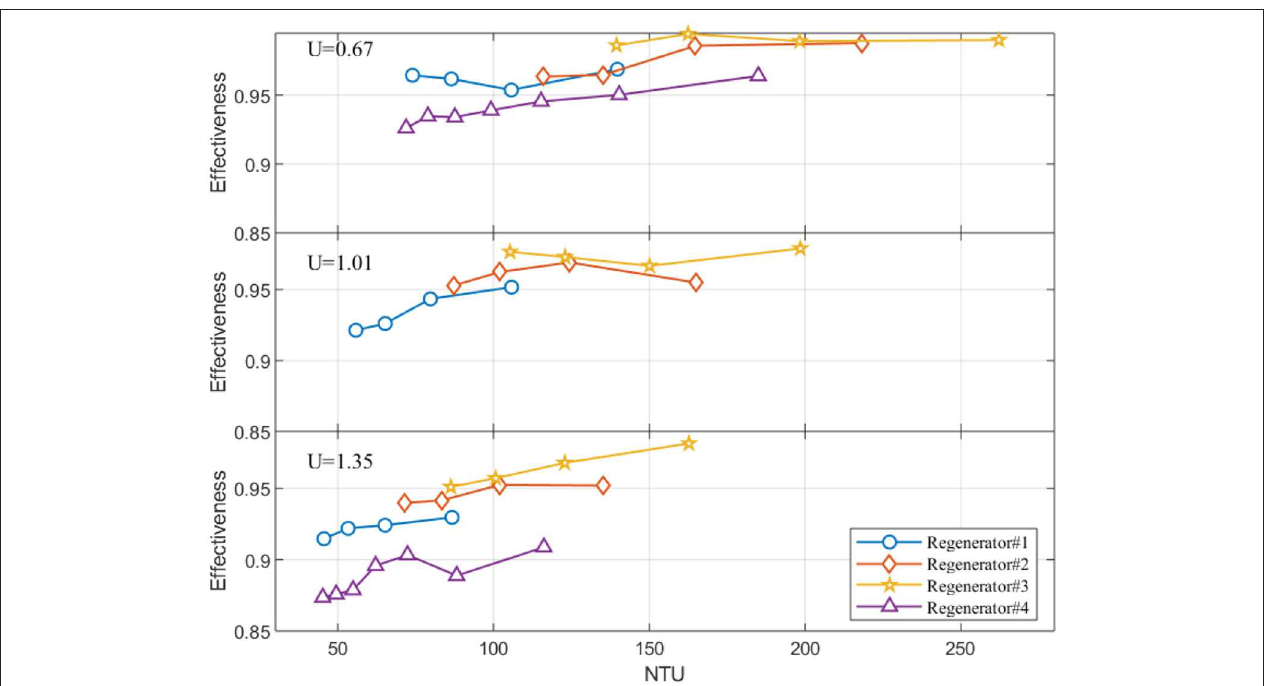
FIGURE 6 | Effectiveness as a function of NTU for different utilizations. The effectiveness is based on hot to cold blow. Since there is regenerator #4, the actual utilization in regenerator #4 is higher than others at the same subplot. The data at regenerator #4 are from our previous publication ( Liang et al., 2020).